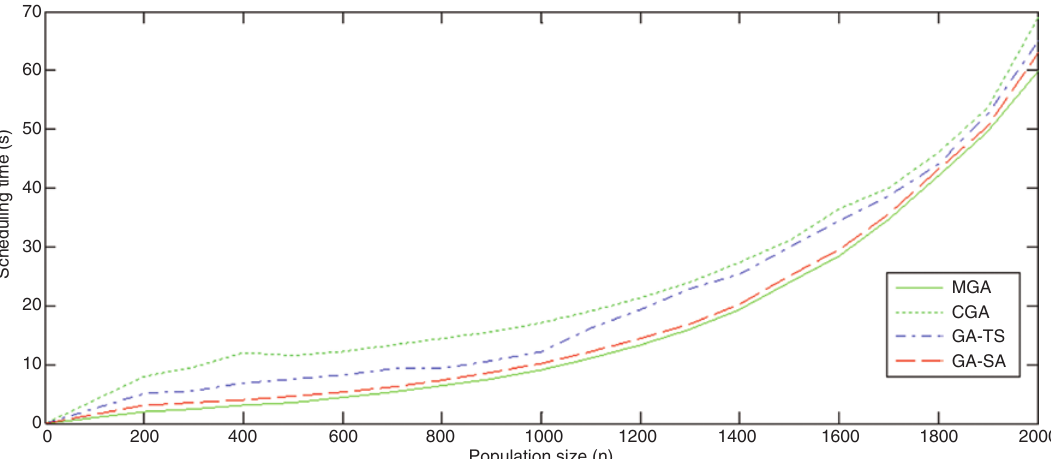
Figure 4: Comparison of Resource Scheduling Time for CGA, MGA, GA-TS, and